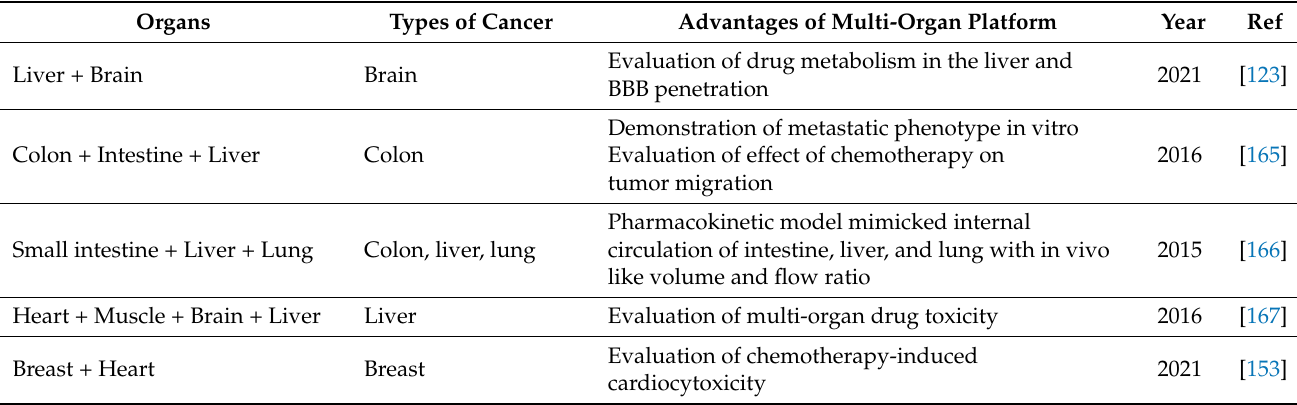
Table 3. Multi-organ microfluidic chips for cancer modeling and drug